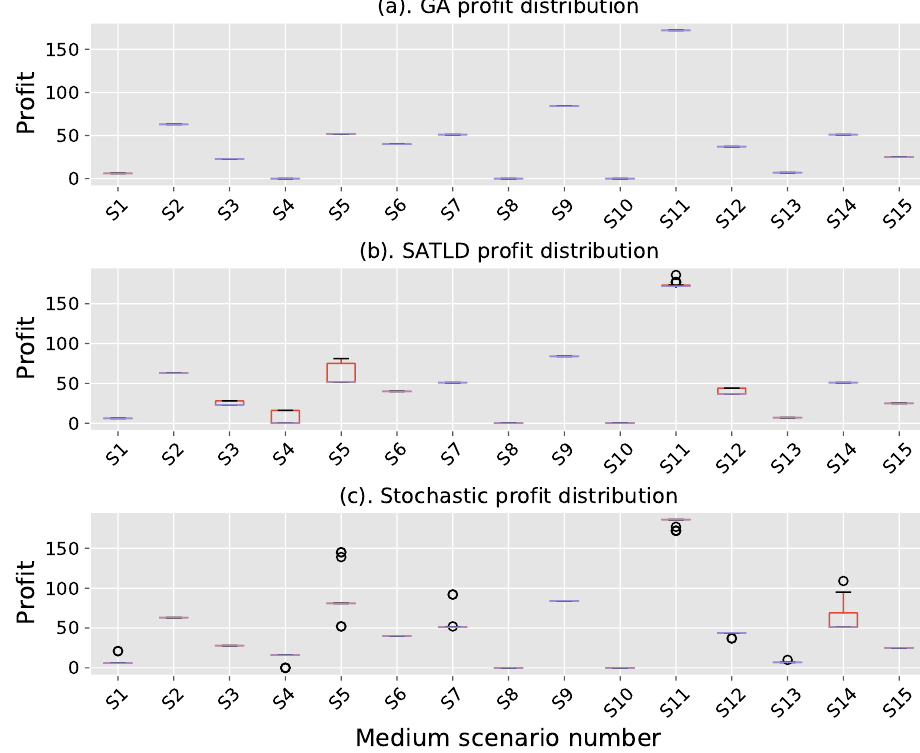
Figure 8. Distribution in medium